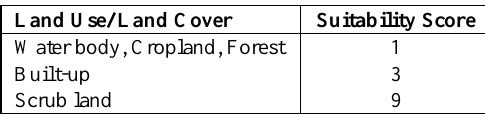
Figure 5. Geomorphology suitability map